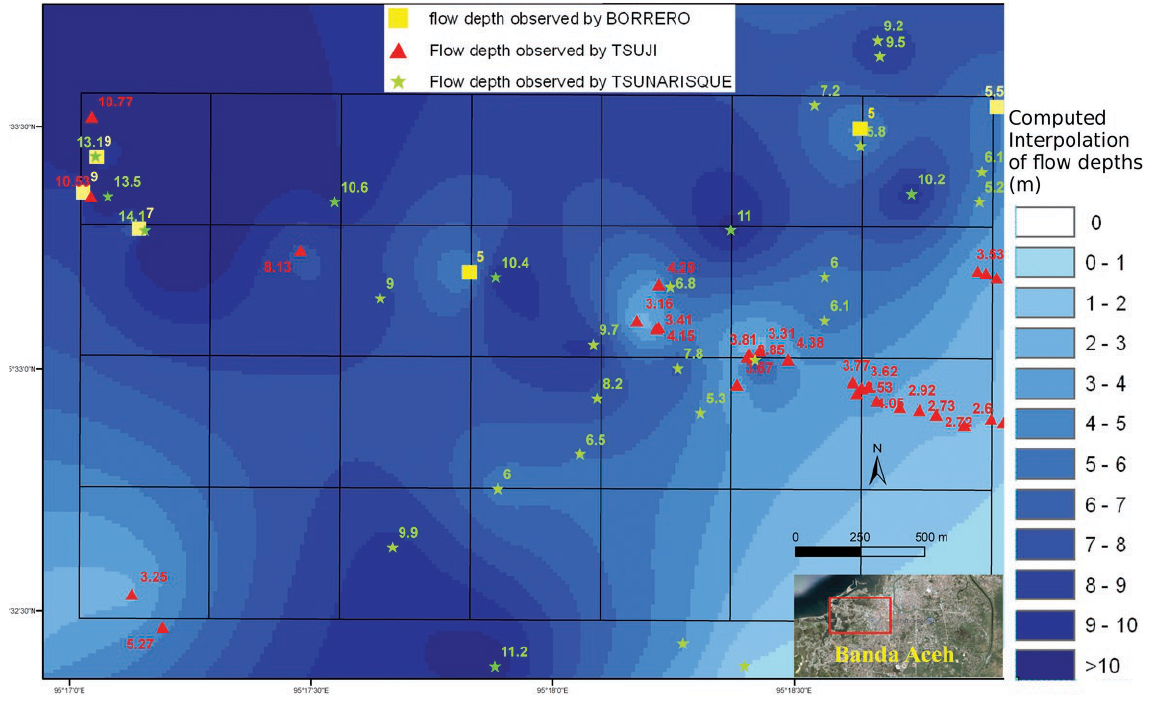
Fig. 2. Computed flow-depth interpolation using Kriging method (grid size 15m) and field measures available for Banda Aceh area (Indone- sia) by three teams. The flow-depth parameter represents the height of the tsunami wave measured from the ground level up to the water mark observed in